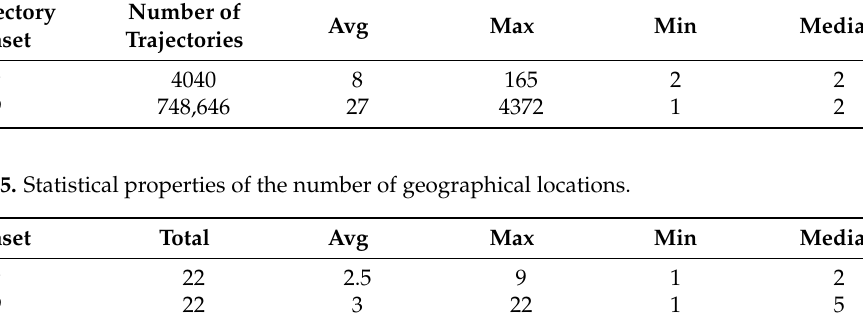
Table 6. The influence of noise filtering on the accuracy of face–phone trajectory matching. Model